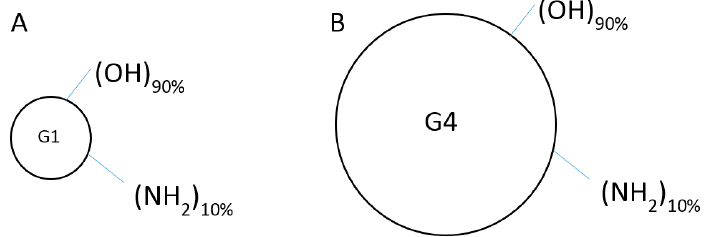
Figure 1. ( A ) G1-90/10 dendrimer having 90% of surface covered with OH (neutral) groups and